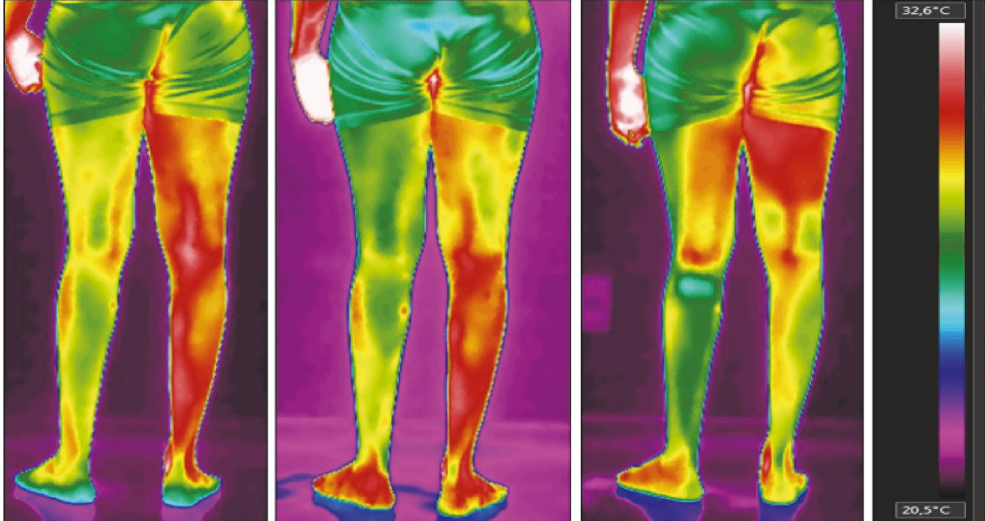
Figure 2: Thermographic image of the posterior regions of thigh and lower leg at baseline, immediately after the robotic training, and 30 minutes after the end of the robotic training (from left to right).